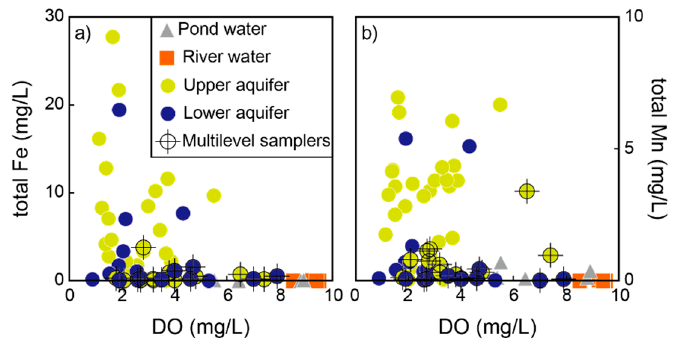
Figure 6. The relationship of dissolved iron (Fe total ); ( a ) and manganese (Mn total ) ( b ) to dissolved oxygen (DO) in groundwater.